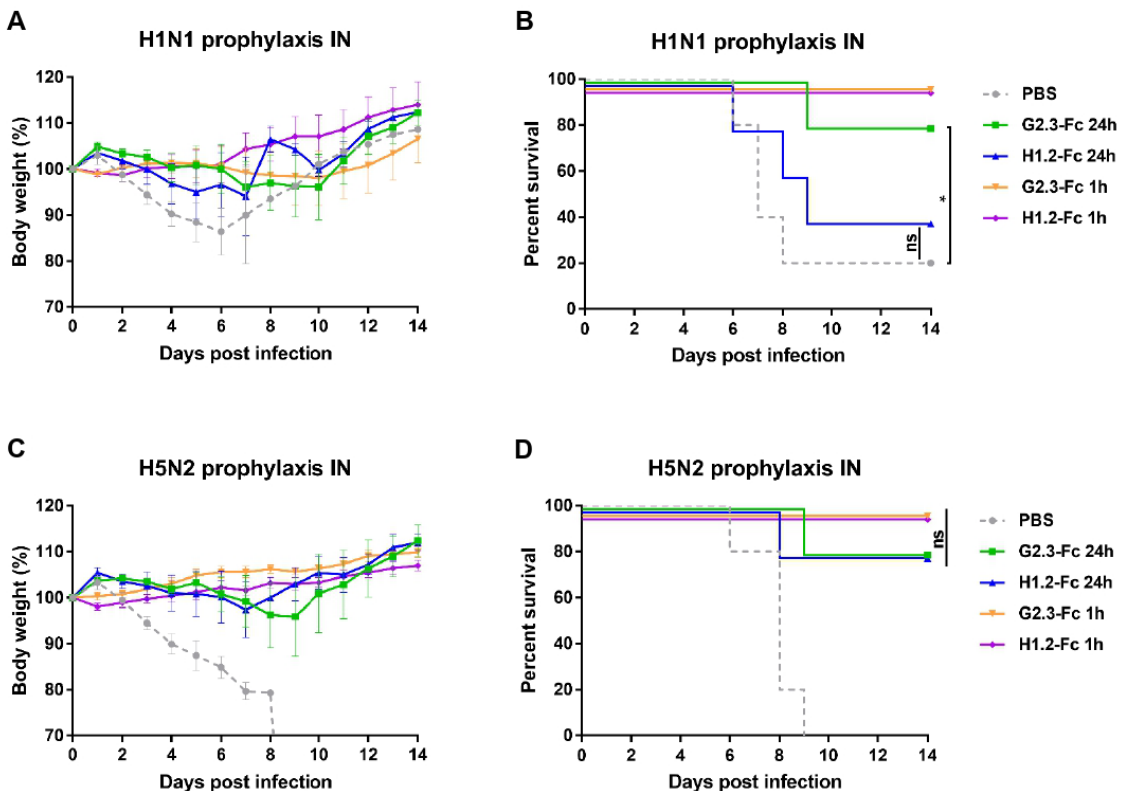
Figure 4. Prophylactic efficacy of locally administered VHH-Fc in mice. Body weight changes and survival curves of mice (n = 5 per group), treated via the i.n. route with G2.3-Fc or H1.2-Fc in a dose of 0.6 mg/kg 24 h or 1 h before infection with influenza CA/09(H1N1)ma virus ( A , B ) or duck/PA/84(H5N2)ma virus ( C , D ). As a negative control, a vehicle (PBS) was administered 1 h before infection via the i.n. route. Body weight curves represent mean value ± SEM. Significant differences between groups are shown: *, p = 0.033;